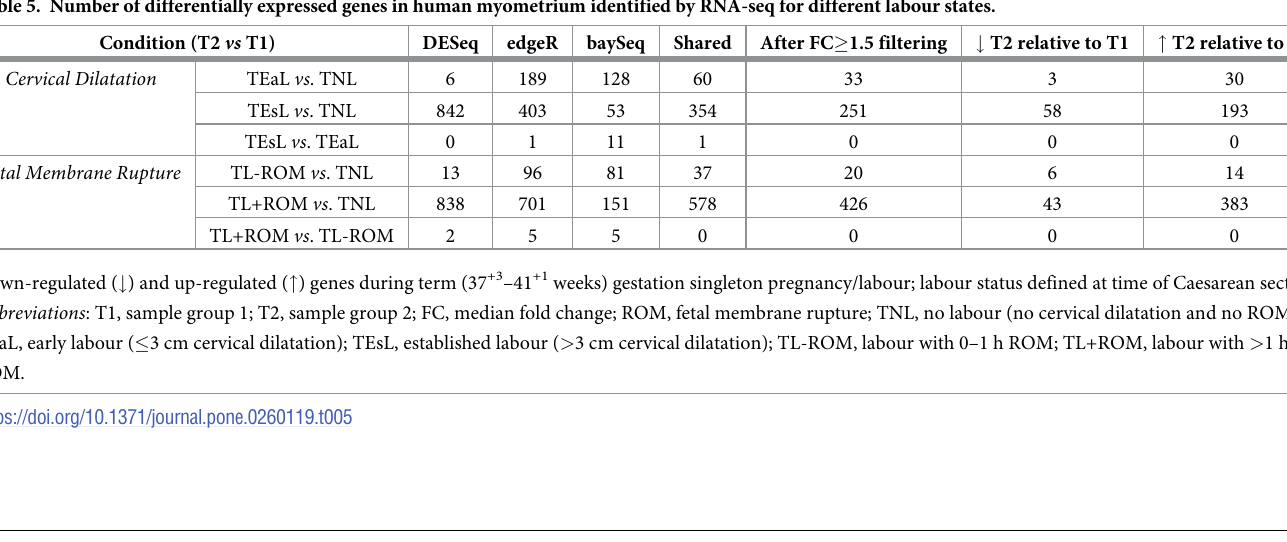
function (MF) and cellular component (CC) GO classes were identified. For labour grouped by cervical dilatation, GO terms enriched from TEaL vs TNL and TEsL vs TNL for all three classes are presented in S3 Dataset, and the top five BP terms are listed in Table 6. Immune/ inflammation-related BP terms dominated the up-regulated DEGs at both TEaL and TEsL; whereas for down-regulated DEGs, ‘rhythmic process’ was the only enriched BP term for TEaL and the top five BP terms for TEsL were all related to the regulation of muscle contrac- tions. For labour grouped by ROM status, all GO terms for BP, MF and CC classes enriched from TL-ROM vs TNL and TL+ROM vs TNL are presented in S4 Dataset, and the top five BP terms are also listed in Table 6. As with cervical dilatation groupings, immune/